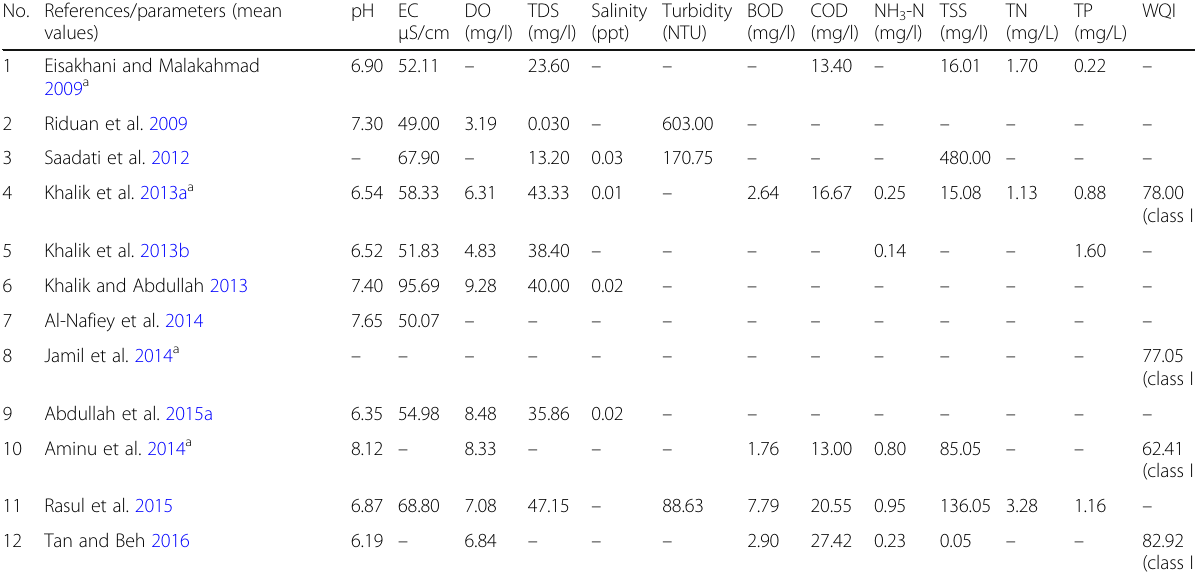
Table 3 Comparison of particular water quality parameters ’ mean values obtained from various studies on rivers and tributaries in Cameron Highlands